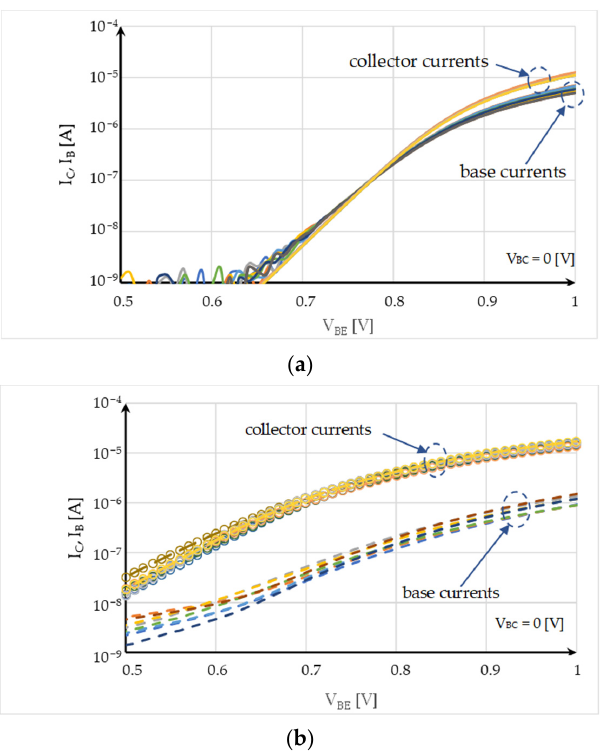
Figure 10. Sets of Gummel plots of the selected F-type devices from the third prototype wafer with complementary devices: ( a ) plots of p-n-p devices; ( b ) plots of n-p-n devices. All measurements are at room temperature (300 K).